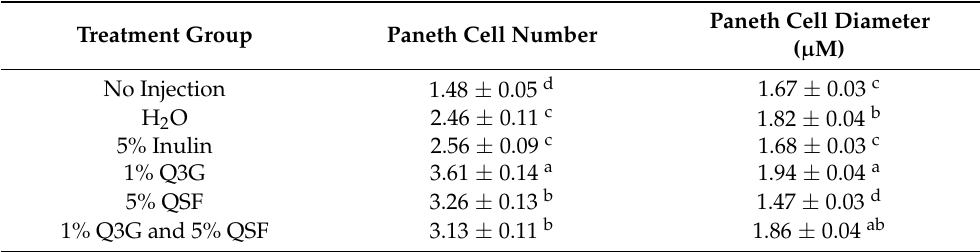
Table 3. Effect of intra-amniotic administration of treatments and controls on Paneth cell number and